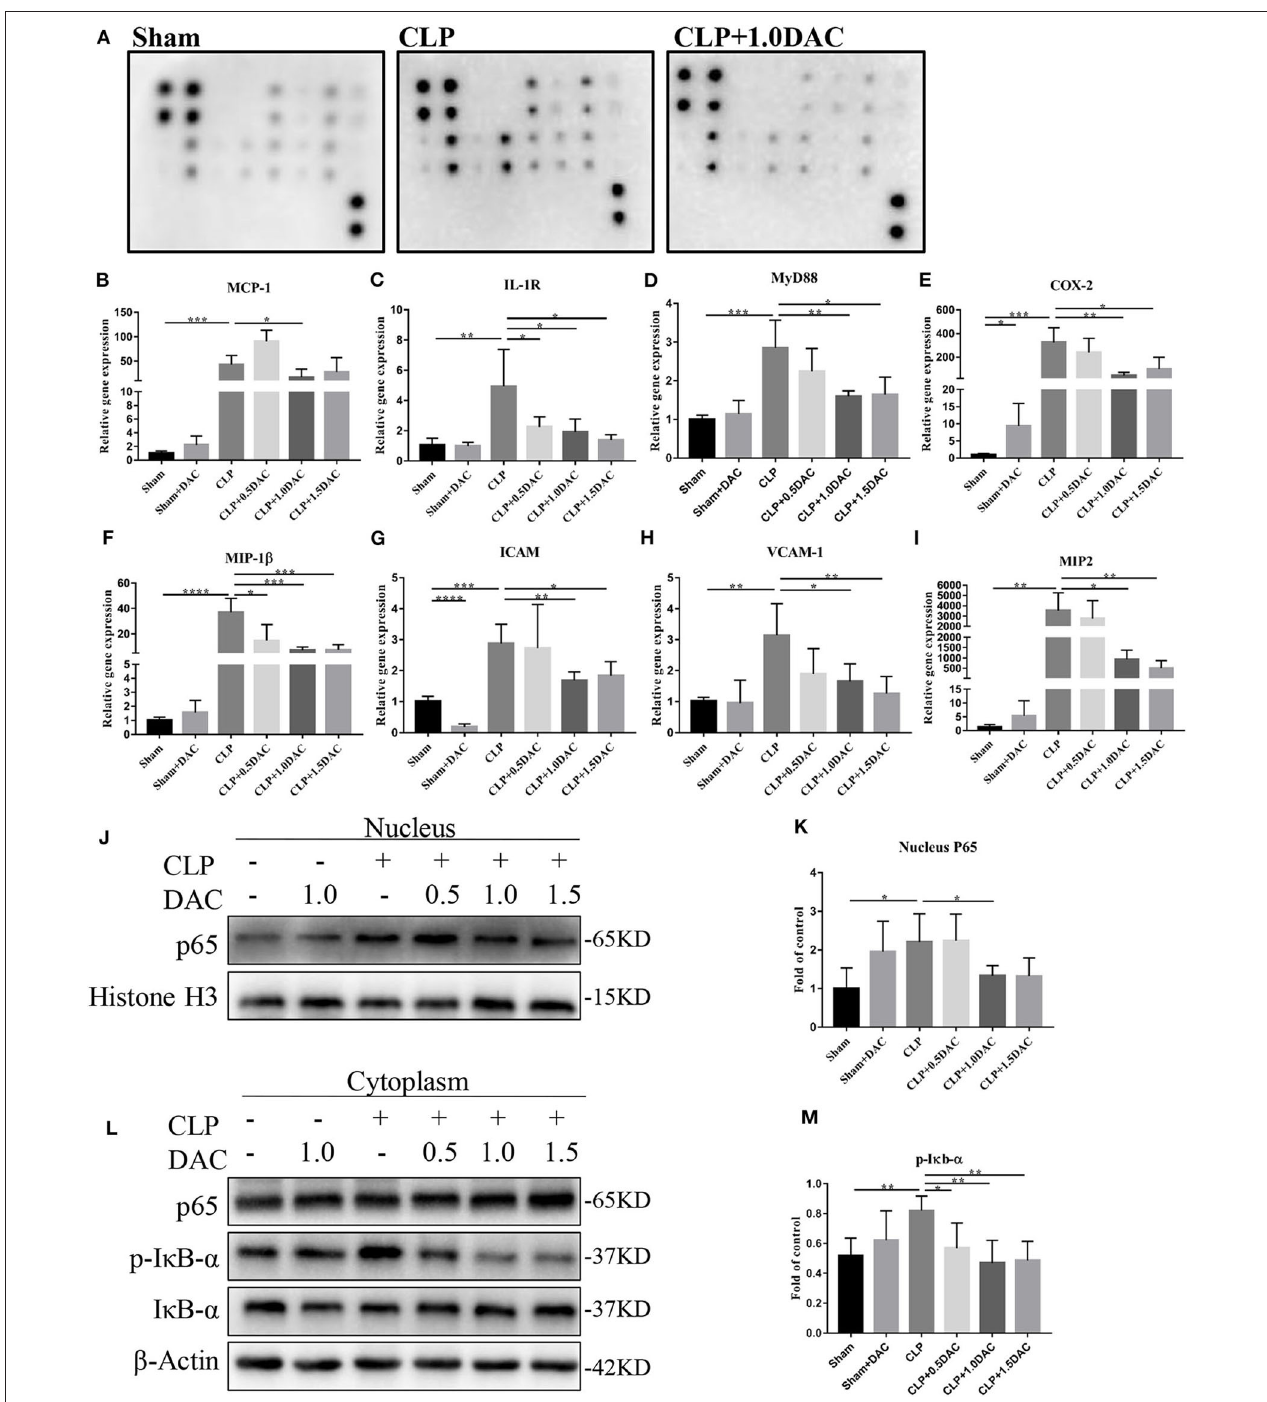
FIGURE 4 | Decitabine attenuated NF- κ B activation in CLP mice. (A) Representative images of cytokine expression levels in spleen lysate of sham, CLP and CLP + 1.0DAC mice. (B–D) Relative mRNA levels of NF-kB upstream targets genes MCP-1, IL-1R, MyD88 in CLP mice spleen samples with or without Decitabine treatment compared with sham group spleen samples. (E–I) Relative mRNA levels of NF- κ B downstream targets genes COX2, MIP-1 β , ICAM, VCAM-1, MIP-2 in CLP mice spleen samples with or without Decitabine treatment compared with sham group spleen samples. (J) Representative western blot for P65 in nucleus fraction of mice spleen with or without Decitabine treatment. (K) The P65 bands were quantified by densitometry and normalized to the density of Histone H3. (L) Representative western blot for P65, p-I κ B − α , I κ B − α in cytoplasm fraction of mice spleen with or without Decitabine treatment. (M) The p-I κ B − α bands were quantified by densitometry and normalized to the density of β -actin n = 5. Data were shown in Mean ± SD. **** p < 0.0001, *** p < 0.001, ** p < 0.01, * p < 0.05. Comparisons between two groups were done by independent student’s t -test.